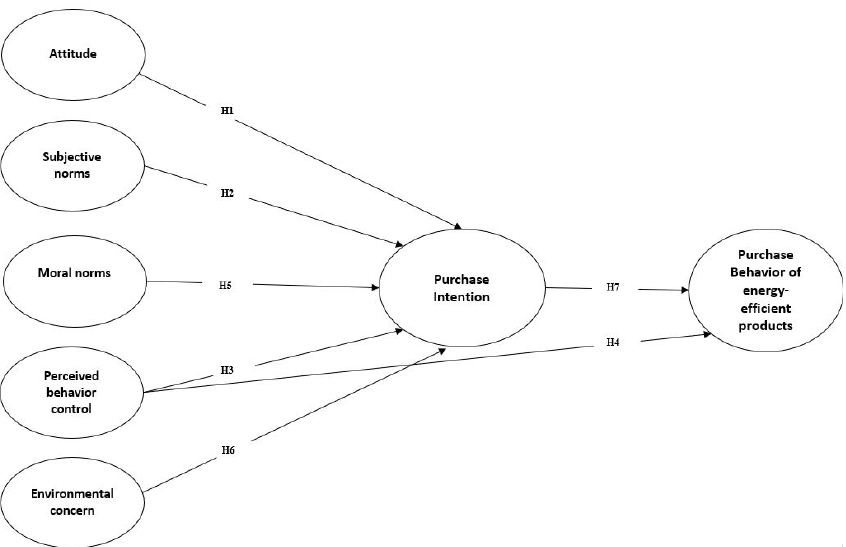
Figure 1. extended model of TPB for measuring consumer purchase intention of energy-efficient appliances (EEAs).